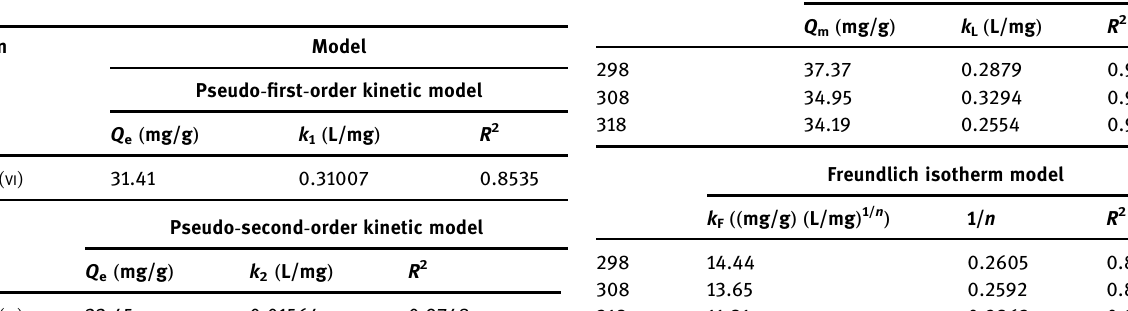
Table 1: Pseudo - fi rst - order together with pseudo - second - order kinetic model parameters within the HM ion system